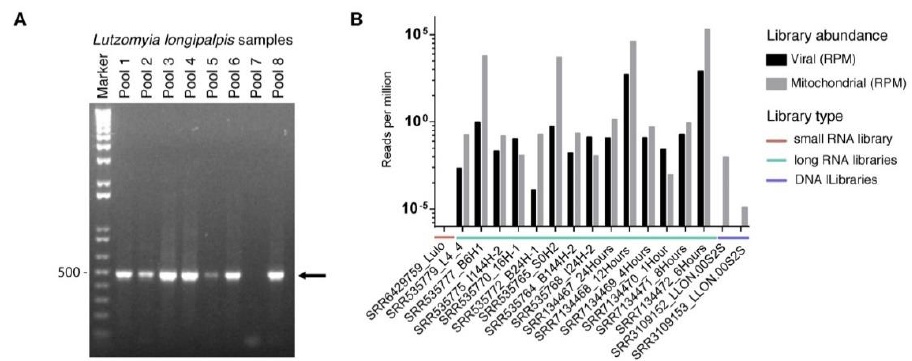
Figure 7. Detection of Lul-MV-1. ( A ) RT-PCR amplification of a Lul-MV-1 target using Lu. longipalpis RNA from different pools of individuals derived from the same colony used to prepare the small RNA deep sequencing libraries. The arrow indicates the amplification product. ( B ) Reads from different RNA and DNA public libraries of Lu. longipalpis mapped onto the genome of Lul-MV-1 with Bowtie2, quantified and resulting numbers normalized by Reads Per Million (RPM).